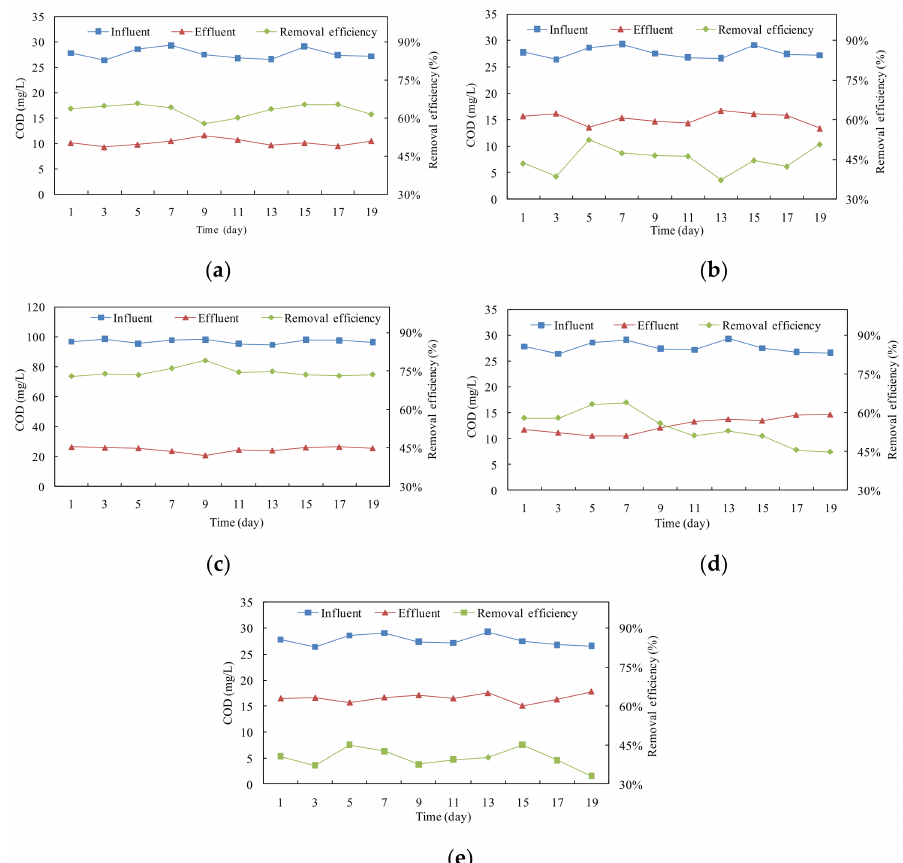
Figure 4. COD removal efficiency in five constructed wetlands (CWs); ( a ) W1, non-added, HRT = 2 days; ( b ) W2, added corn straw, HRT = 2 days; ( c ) W3, added sodium acetate, HRT = 2 days; ( d ) W4, added corn straw, HRT = 3 days; and ( e ) W5, added corn straw, HRT = 1